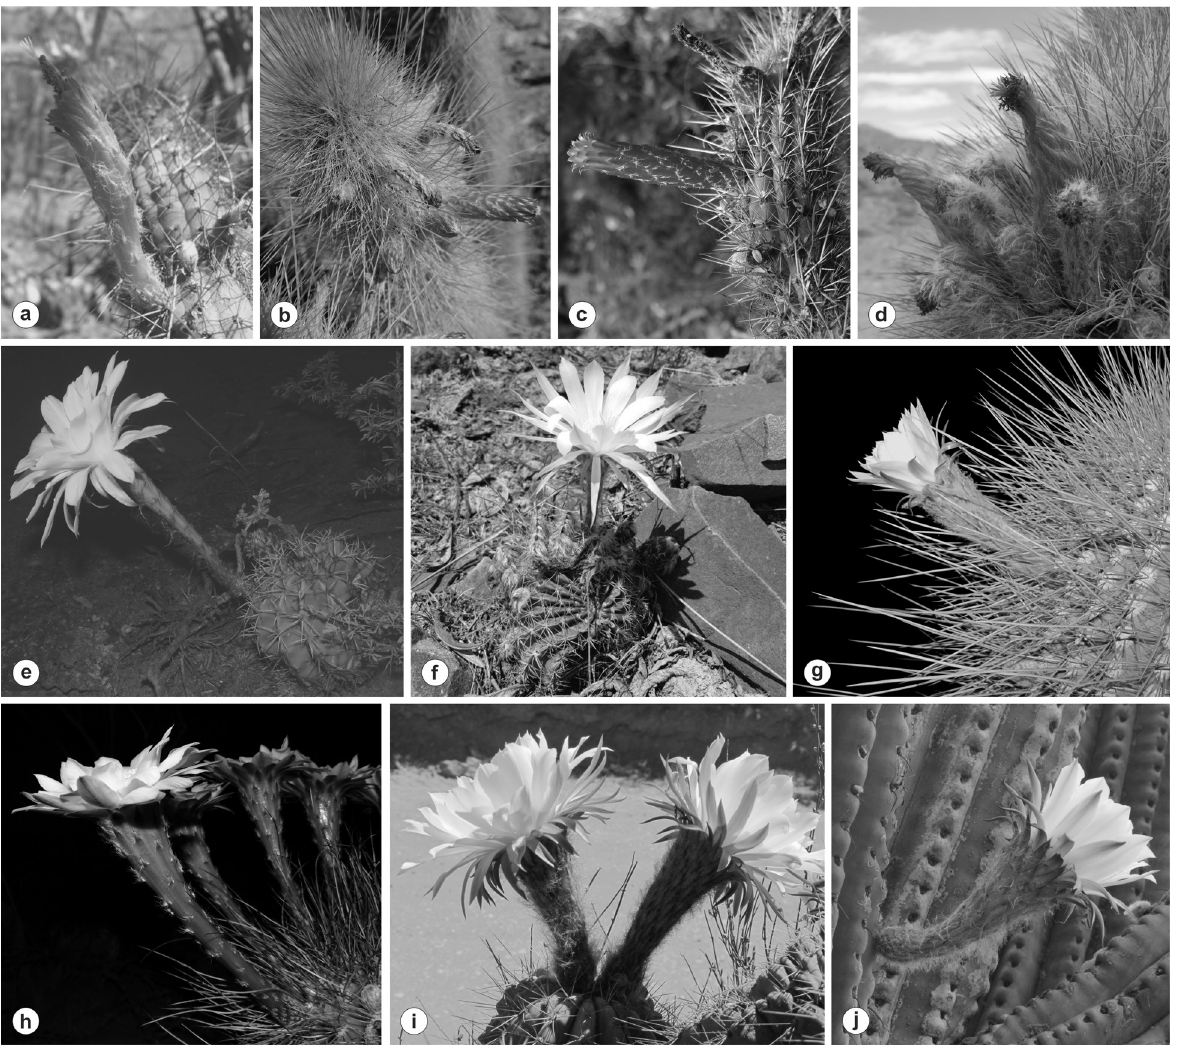
Figure 1. a-d Ornitophilous flowers of cactus. a Cleistocactus baumannii, detail of sigmoid tubular flower. b C. hyalacanthus, detail of upper portion of stem with buds, flowers in anthesis and fruits. c C. smaragdiflorus , detail of tubular flower, note green tepals. d Denmoza rhodacantha, detail of buds and sigmoid tubular flowers at the apex of the stem. e-j Sphingophilous flowers. e Echinopsis albispinosa, plant and infundibuliform flower. f E. ancistrophora , plant and flower still open early in the morning. g E. atacamensis, detail of infundibuliform flower. h E. leucantha , detail of a set of flowers. i E. schickendantzii , detail of two flowers. j E. terscheckii , detail of flower. Photographs: V. González a-c, P. Gorostiague